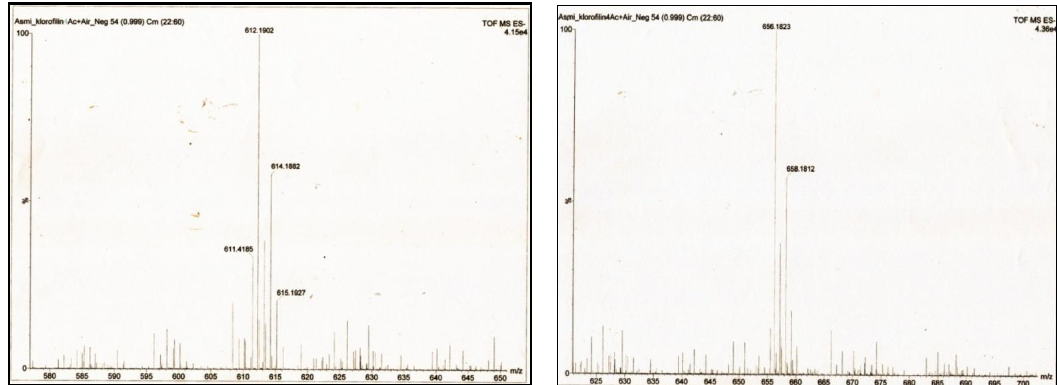
Figure 1. The scheme of chlorophyllin complexed conversion into carboxylic acid form.